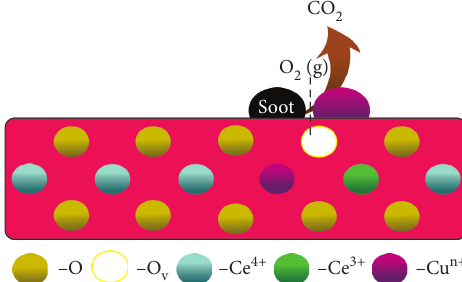
Figure 5: The oxidation of diesel soot over the interface of CuO x -CeO 2